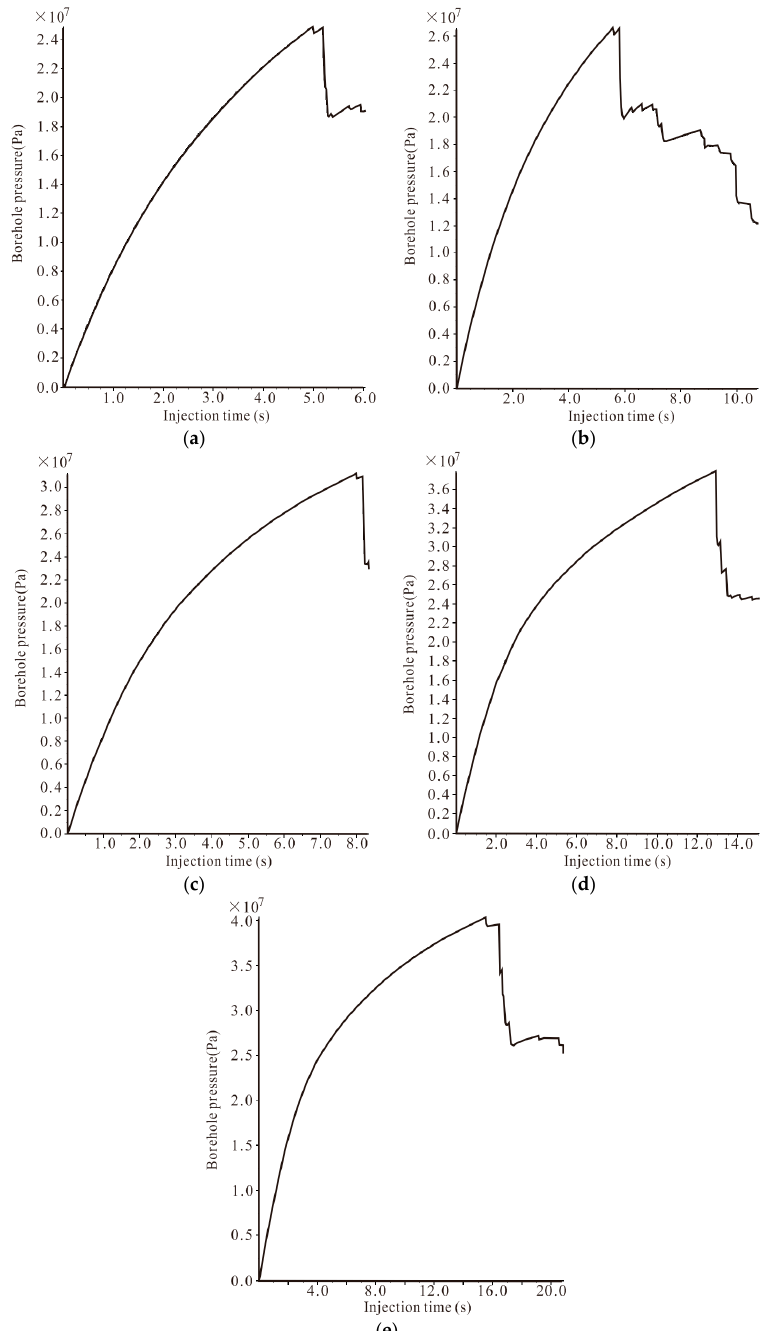
Figure 7. Fluid pressure history at injection borehole during hydraulic fracturing simulation under different confining pressure in y ‐ direction: ( a ) S h = 12.0 MPa; ( b ) S h = 13.0 MPa; ( c ) S h = 15.0 MPa; ( d ) S h = 18.0 MPa; and ( e ) S h = 20.0 MPa.